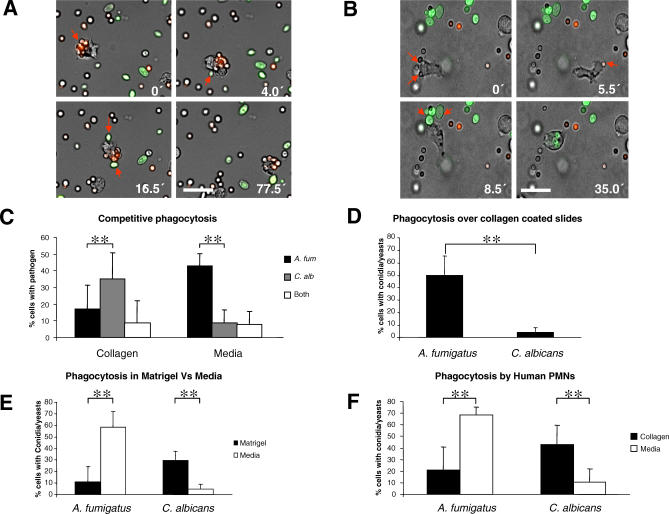
Phagocytosis of A. fumigatus and C. albicans Is Dependent on the Dimensionality of the EnvironmentPMNs were incorporated along with A. fumigatus conidia and C. albicans yeast cells in the same system (2-D or 3-D), and the interactions were observed over a period of 3 h.(A) A PMN selectively taking up and dragging A. fumigatus conidia despite several contacts with C. albicans yeasts in a 2-D liquid system. Bar = 25μm.(B) Time series of a PMN selectively taking up three C. albicans cells despite touching at least four A. fumigatus conidia in 3-D (red arrows). Bar = 25 μm.(C) Quantitative representation of cells with internalized A. fumigatus conidia or C. albicans yeast cells or both in 2-D or 3-D systems. Data represent the average percentage of cells carrying conidia and/or yeasts from three independent experiments, representing 140 PMNs in collagen and 217 PMNs in media with error bars denoting SD. **, p < 0.01.(D) Quantitative comparison of the percentage of PMNs internalizing conidia or yeasts over collagen coated slides. The graph represents data from three independent experiments. Error bars denote SD. **, p < 0.001.(E) Average percentage of PMNs internalizing A. fumigatus or C. albicans in Matrigel (solid bar) and in media (open bar). Data represent the average from three independent experiments. Error bars indicate SD. **, p < 0.001 for both pathogens in 2-D and in 3-D environments.(F) Average percentage of PMNs derived from peripheral human blood with internalized conidia or yeasts in 2-D or 3-D systems. Data represent the average of cells taken from three healthy blood donors, each analyzed for all four conditions. Error bars indicate SD. **, p < 0.001.